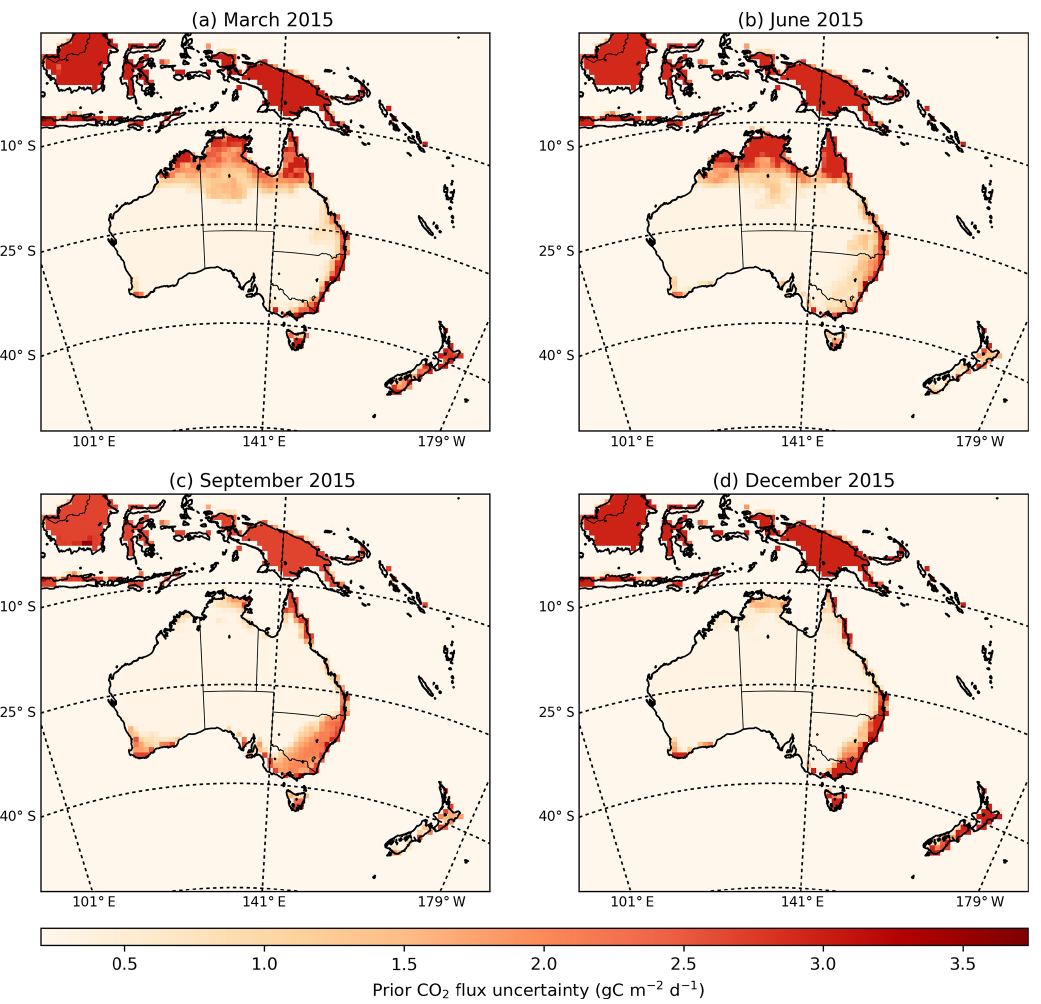
Figure 3. Monthly mean of CO 2 prior uncertainties accounting for the major terms in the CO 2 budget (anthropogenic fluxes, fires, land and ocean exchange) (in units of gCm − 2 d − 1 ).